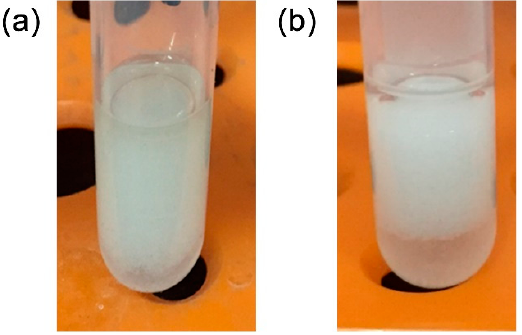
Figure 1. Optical images of emulsions obtained by shaking the oil-water mixture of ( a ) MIPs and ( b ) non-imprinted polymers (NIPs).